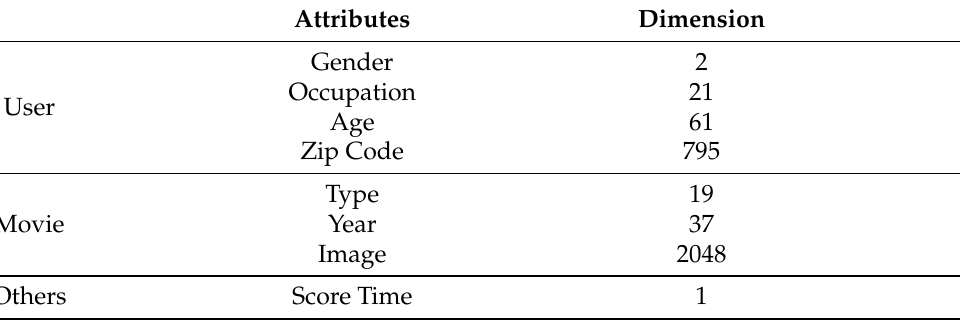
Table 2. The processed attributes of the MovieLens